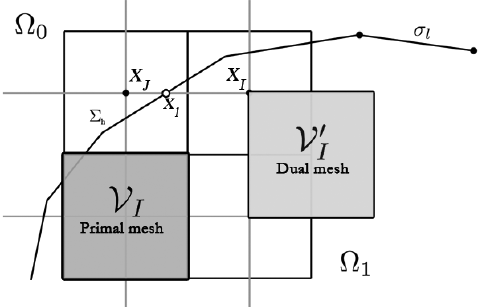
Figure 2. Definition of the discretization